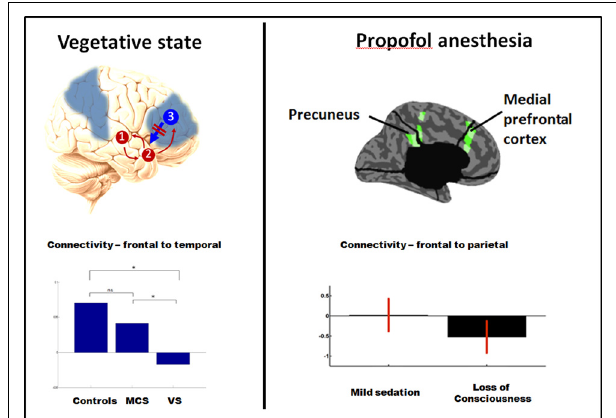
FIGURE 2 | PET studies reveal hypometabolism in similar fronto-parietal areas in vegetative and anesthesia (areas in blue, left panel). Recent dynamic causal modeling studies also suggest a loss of top-down (reentrant) connectivity in fronto-parietal cortices in both vegetative state (left panel, assessed for response to auditory stimuli) and propofol anesthesia (right panel, assessed from spontaneous EEG). Adapted from Boly et al. (2011, 2012a). ∗ Significant difference between conditions (corrected p < 0 . 05).